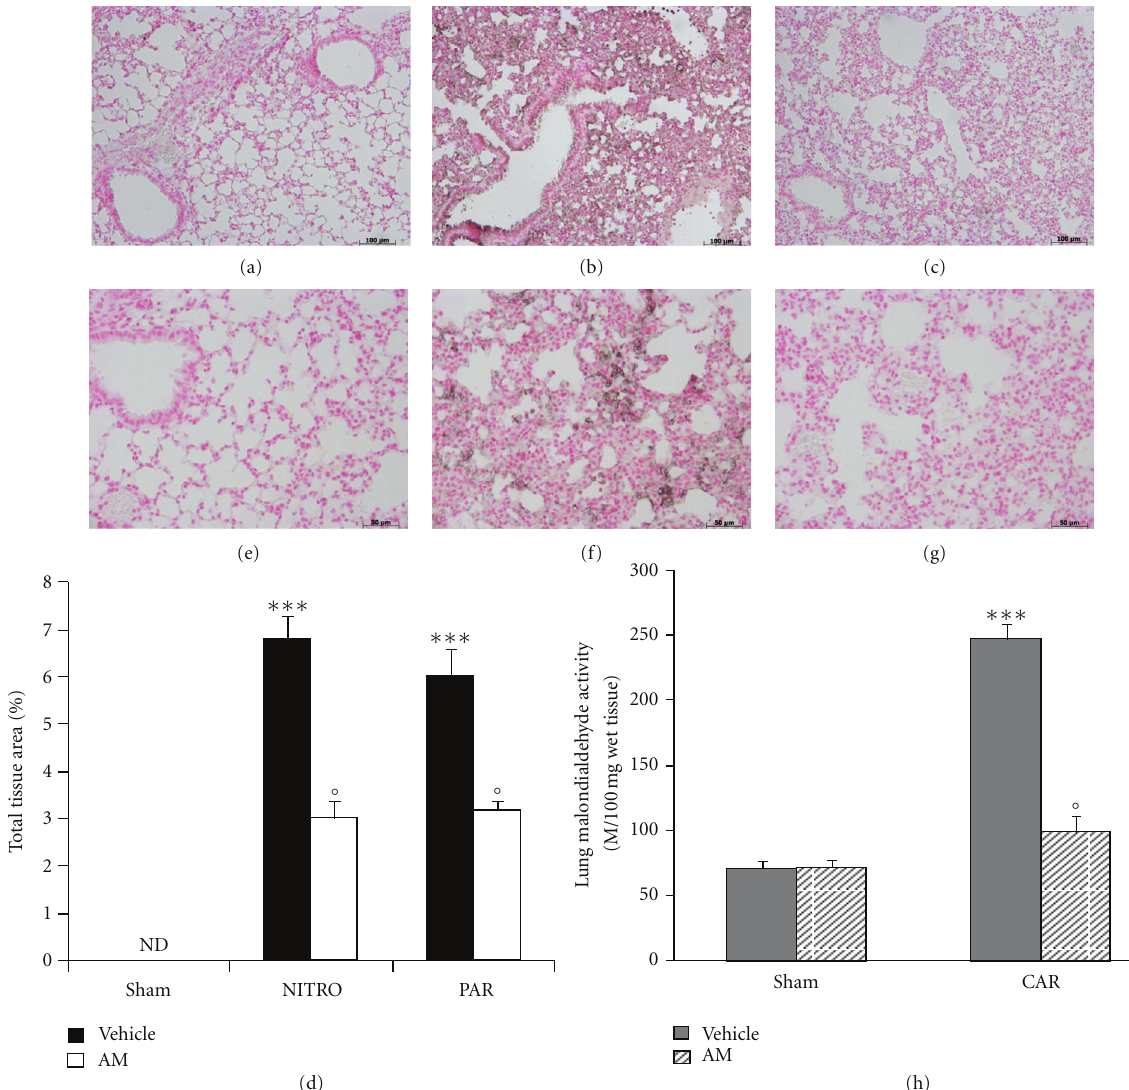
Figure 4: E ff ect of adrenomedullin (AM) on nitrotyrosine formation, lipid peroxidation, and PARP activation. No staining for nitrotyrosine is present in lung section from sham mice (a). Lung sections taken from CAR-treated mice treated with vehicle showed positive staining for nitrotyrosine, localized mainly in inflammatory cells (b). There was a marked reduction in the immunostaining for nitrotyrosine in the lungs of CAR-treated mice treated with AM (c). Malondialdehyde (MDA) levels, an index of lipid peroxidation, were significantly increased in lung tissues 4h after CAR administration (h), if compared with lung from sham mice (h). AM significantly reduced the CAR-induced elevation of MDA tissue levels (h). Lung sections taken from CAR-treated mice showed positive staining for PAR (f). There was a marked reduction in the immunostaining for PAR in the lungs of CAR-treated mice treated with AM (g). Lung section from sham mice showed no staining for PAR (e). Densitometry analysis of immunocytochemistry photographs ( n = 5 photos from each sample collected from all mice in each experimental group) for nitrotyrosine and PAR from lung tissues was assessed (d). The assay was carried out by using Optilab Graftek software on a Macintosh personal computer (CPU G3-266). Data are expressed as % of total tissue area. The figure is representative of at least 3 experiments performed on di ff erent experimental days. Data are expressed as mean ± s.e.m. from n = 10 mice for each group. ∗ P < 0 . 01 versus sham group. ◦ P < 0 . 01 versus